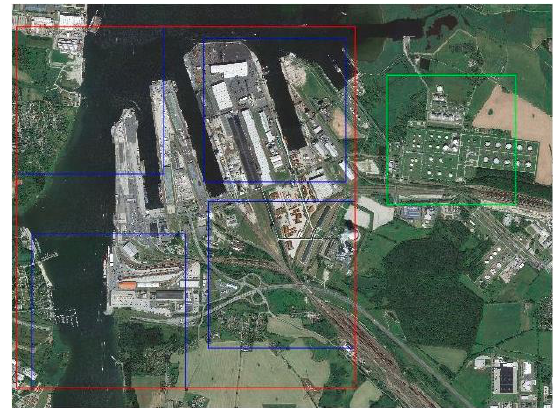
Figure 6. Detection on Busan Port in Republic of Korea